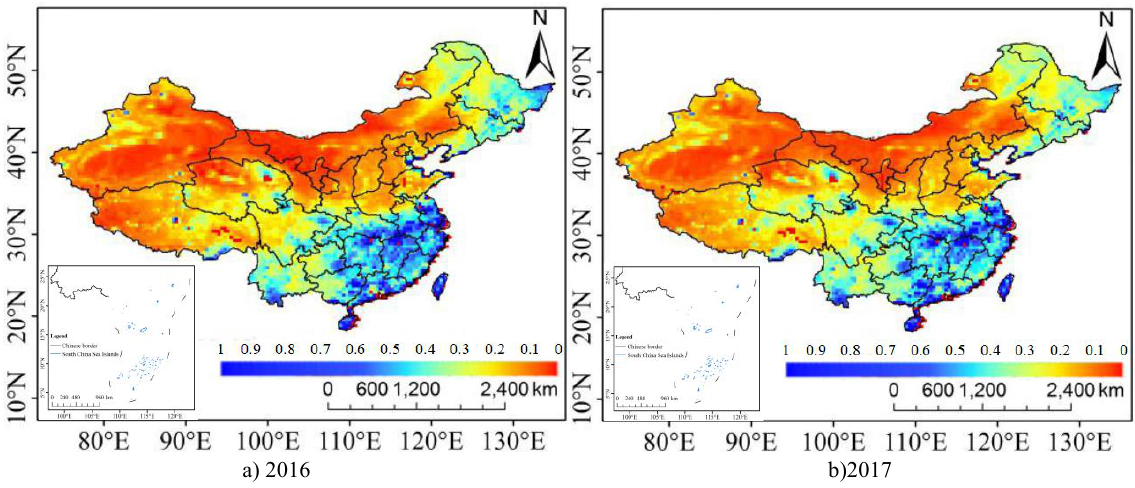
Figure 4 Annual Distribution of Mean Soil Moisture in China in 2016 and